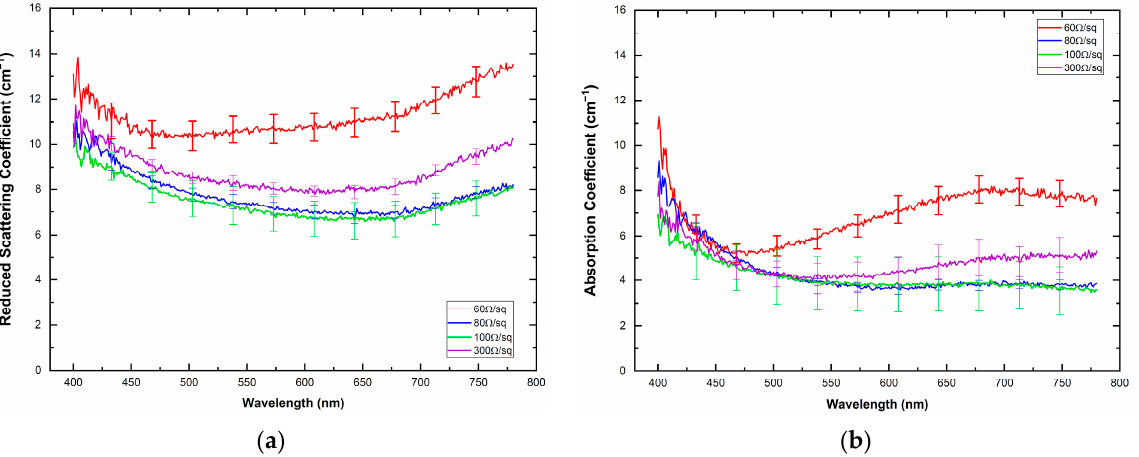
Figure 4. Reduced scattering coefficient ( a ) and absorption coefficient ( b ) of the ITO-PET electrodes. Solid lines correspond to the mean value extracted from the measurements and their corresponding standard deviation is also indicated as vertical lines.